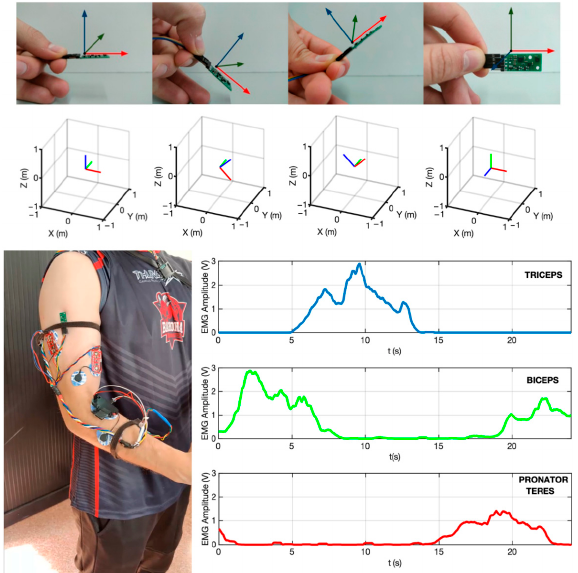
Figure 3. Current ARMIA prototype showing actual location of sensors ( bottom-left ). EMG signals obtained from the muscles of interest ( bottom-right ). Inertial sensor measurements ( top ). 4. System Validation In order to validate the first prototype of ARMIA, several experiments were per- formed. The main goal was to evaluate how accurate are the recorded signals from the